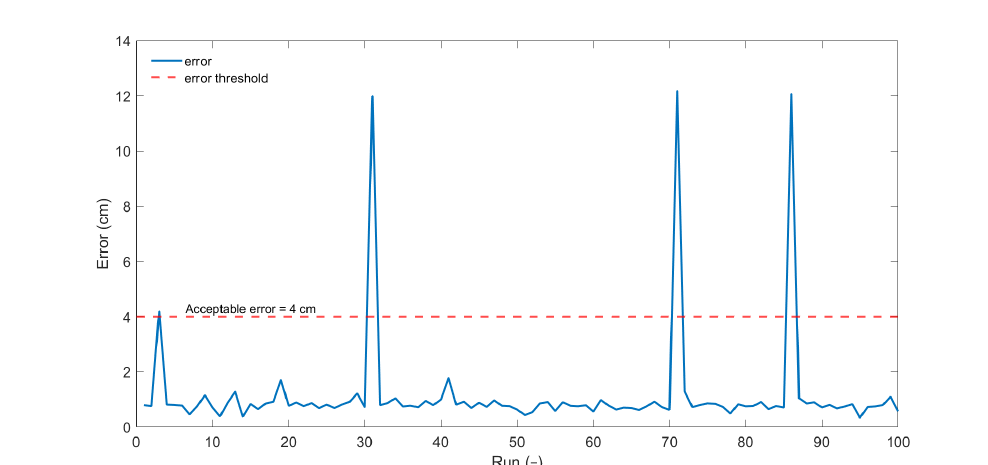
Figure 9. Error in damage localization for damage 7 for 100 PSO runs.